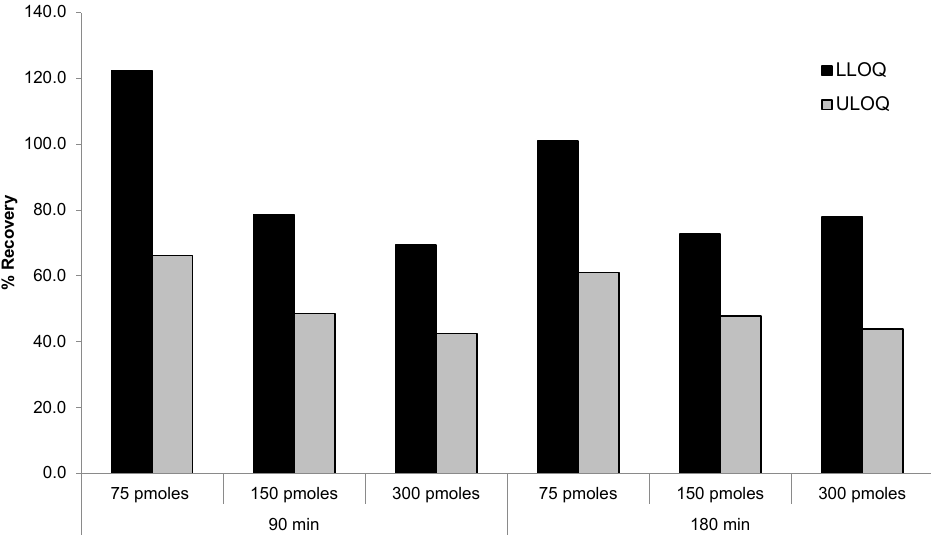
Figure 4. Effect of DNA probe concentration and incubation time on the recovery of siRNA-01.